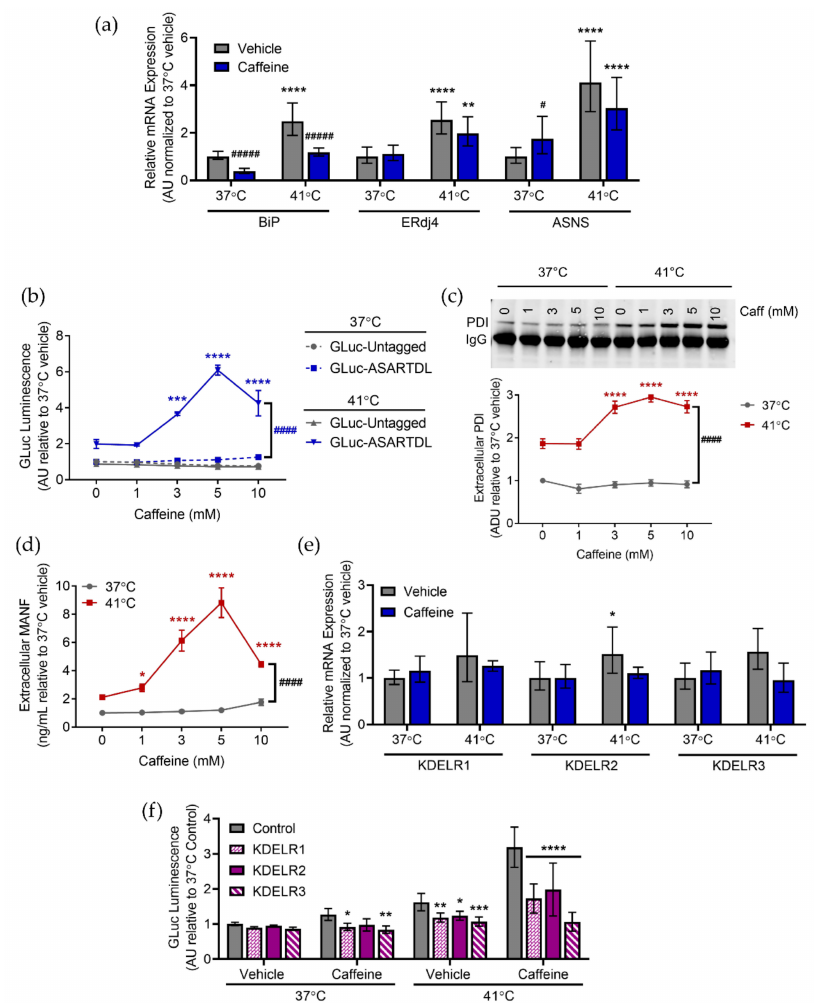
Figure 4. Caffeine changes cellular responses to hyperthermia. ( a ) BiP , ERdj4 , and ASNS mRNA levels analyzed with real-time RT-qPCR after treatment with vehicle or 5 mM caffeine and an 8 h exposure to 37 ◦ C or 41 ◦ C. Data are shown as relative mRNA expression (arbitrary units: AU) relative to con- trol (2 − ddCq ± upper and lower limits, n = 8, two-way ANOVA with Sidak’s multiple comparisons, ** p < 0.01 and **** p < 0.0001 37 ◦ C vs. 41 ◦ C, # p < 0.05, ##### p < 0.001 vehicle vs. caffeine). ( b ) GLuc (arbitrary units: AU) in the media from SH-SY5Y cells stably expressing GLuc-ASARTDL or GLuc-Untagged after treatment with vehicle or caffeine and a 24 h incubation at 37 ◦ C or 41 ◦ C (mean ± SEM, n = 26, two-way ANOVA with Tukey’s multiple comparisons, #### p < 0.0001 37 ◦ C vs. 41 ◦ C, *** p < 0.001 and **** p < 0.0001 vehicle vs. caffeine). ( c , d ) Fold change in ( c ) arbitrary density units (ADU) of immunoprecipitated PDI (representative blot shown) or ( d ) MANF in me- dia from SH-SY5Y cells treated with vehicle or caffeine and incubated for 24 h at 37 ◦ C or 41 ◦ C (mean ± SEM, n = 6, two-way ANOVA with Dunnett’s multiple comparisons, #### p < 0.0001 37 ◦ C vs. 41 ◦ C, * p < 0.05 and **** p < 0.0001 vehicle vs. caffeine). ( e ) KDELR1 , KDELR2 , and KDELR3 mRNA levels analyzed with real-time RT-qPCR after treatment with vehicle or 5 mM caffeine and an 8 h exposure to 37 ◦ C or 41 ◦ C. Data are shown as relative mRNA expression (arbitrary units: AU) relative to control (2 − ddCq ± upper and lower limits, n = 8, two-way ANOVA with Sidak’s multiple comparisons, * p < 0.05 37 ◦ C vs. 41 ◦ C). ( f ) GLuc (arbitrary units: AU)in media following transduction of SH-SY5Y cells stably expressing GLuc-ASARTDL with lentiviral KDEL receptors and treatment with vehicle or 5 mM caffeine and a 24 h exposure to 41 ◦ C (mean ± SEM, n = 9, two-way ANOVA with Dunnett’s multiple comparisons, p < 0.0001 37 ◦ C vs. 41 ◦ C, * p < 0.05, ** p < 0.01, *** p < 0.001, and **** p < 0.0001 control vs.